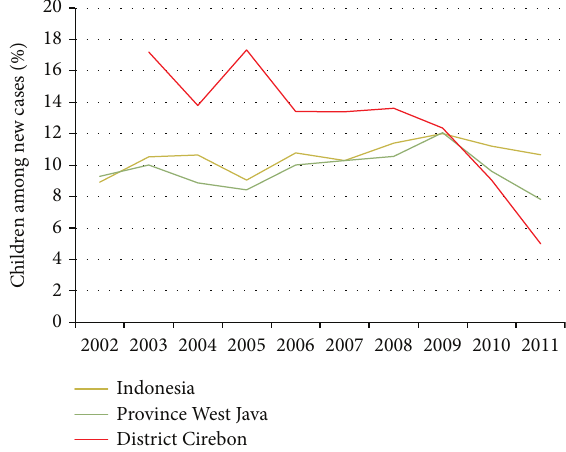
Figure3:10-yeartrendof%childrenamongnewcasesinIndonesia, West Java and Cirebon in 2002–2011 (data is merged from [21,